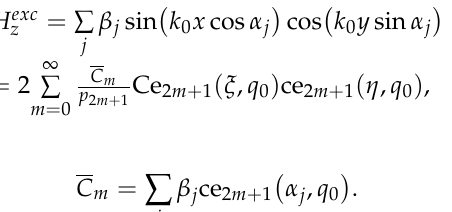
Multiphysics. For the excitation field (18), α = atan ( a / b ) = 1.0122 ≈ π /3. The vertical dashed lines show the position of the mode frequencies. The asterisks on the black curve show the Q factor value of the modes. The insets show the H z distribution for the perfect modes.